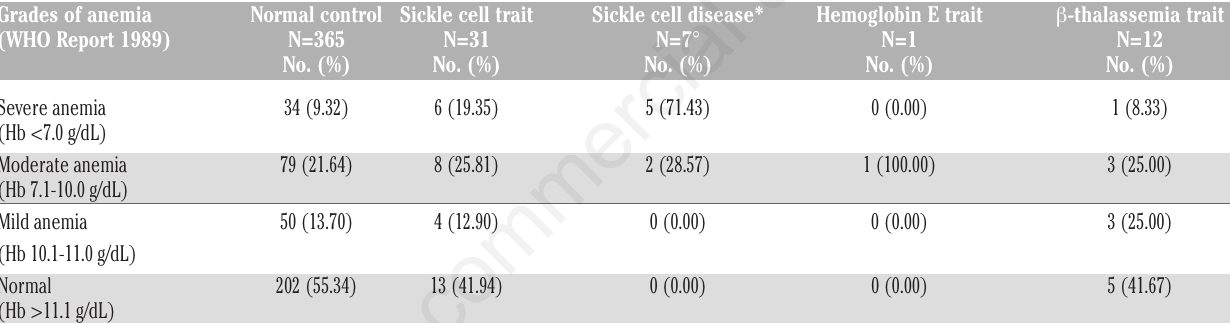
Table 2. Different grades of anemia in pregnant women with and without hemoglobinopathies. Grades of